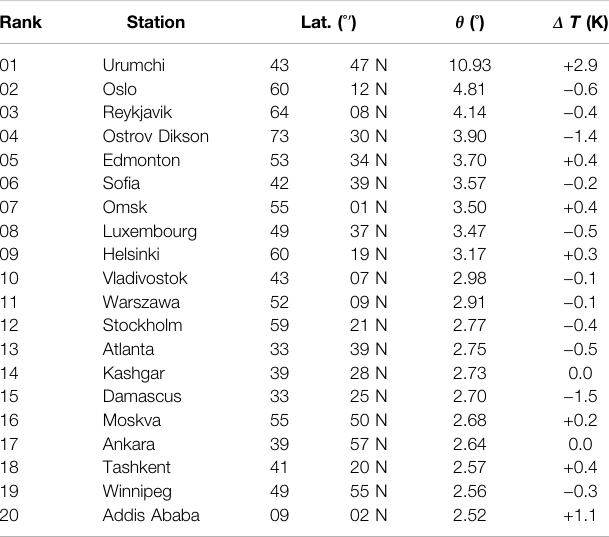
TABLE 1A | Top-twenty World stations in the intersecting angle of the monthly temperatures from Period I (from 1931 to 1960) to Period II (from 1951 to 1980).